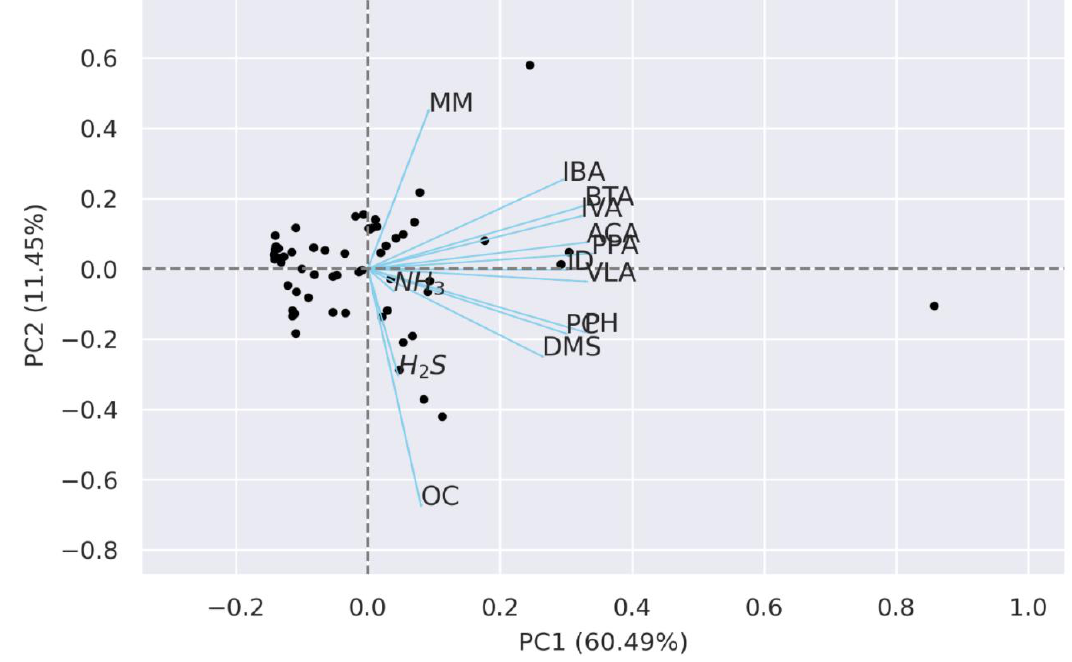
Figure 11. The loading plot about PC1 and PC2.